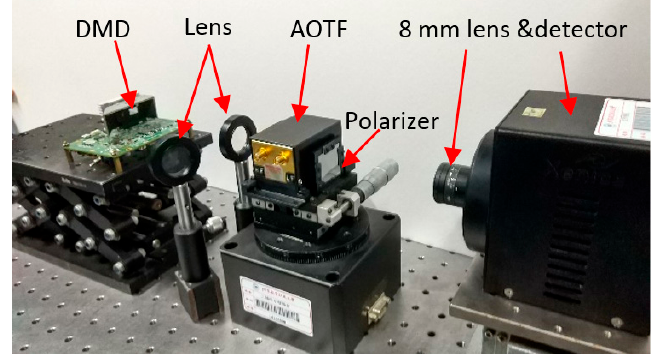
Figure 11. Real conditions of the experimental setup. A polarizer was used to suppress stray light. The lens was focused on the DMD.